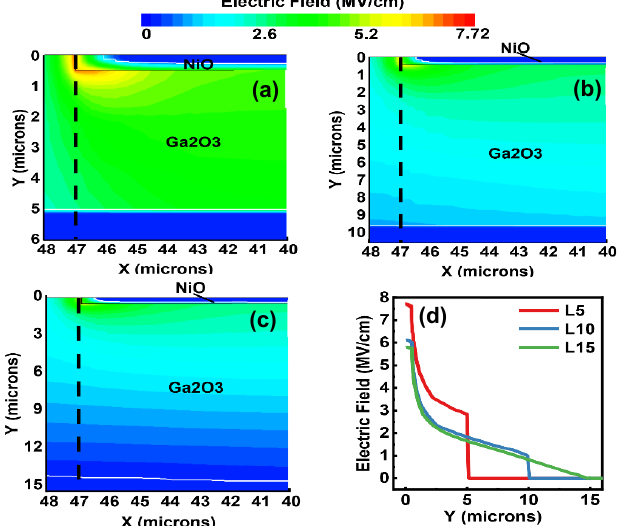
Figure 9. 2D electric field distribution in SBD with the 42 ‐μ m ‐ width NiO for ( a ) 5 μ m, ( b ) 10 μ m, and ( c ) 15 μ m drift layer thicknesses at reverse bias of 2000 V, respectively. ( d ) Electrical field versus position for SBD with 5 μ m, 10 μ m, and 15 μ m drift layer thicknesses at − 2000 V along the cutlines shown in the contour plots.